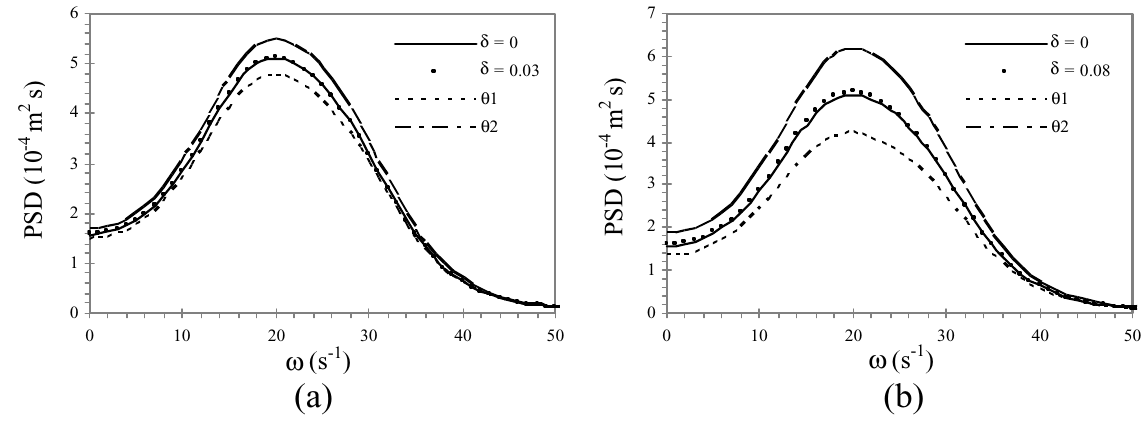
Fig. 3. Y 20 -PSD confidence region for dispersion parameters δ M = δ C = δ K = δ (a) for δ = 0.03 and; (b) for δ =